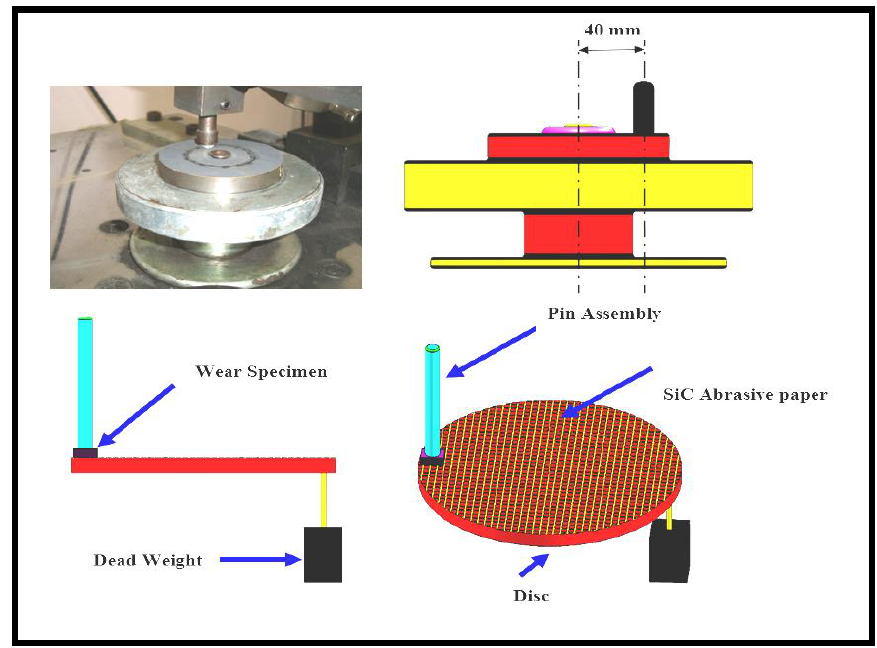
Figure 2. Schematic illustrations of a pin disc machine and image of a two-body wear abrasive set up.